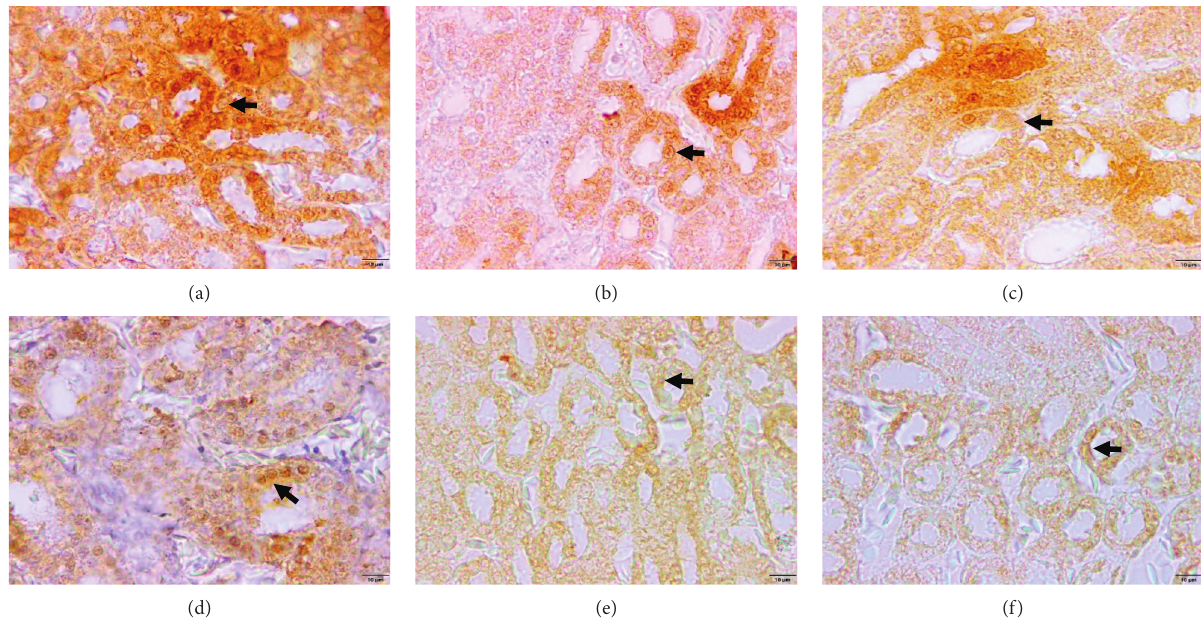
Figure 5: Results of HSP70 protein staining on tissue in chicken kidneys on a scale of 10mm. (a) HS +0, HSP70 positive in tubule cells (dark brown). (b) HS+ 50, HSP70 positive in tubule cells (brown). (c) HS+100, HSP70 positive in tubule cells (light brown). (d) nHS+0, HSP70 positive in tubule cells (brown). (e) nHS+50, HSP70 positive in tubule cells (light brown). (f) nHS+100, HSP70 positive in tubule cells (light